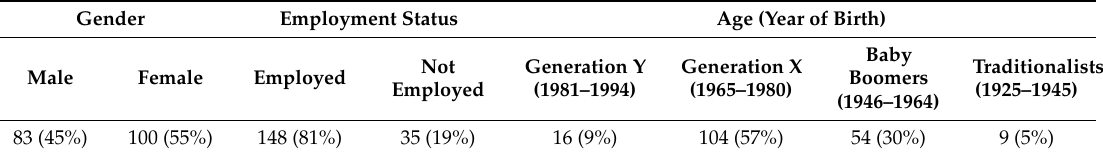
Table 1. Participant demographic profile (raw number and % of total sample).